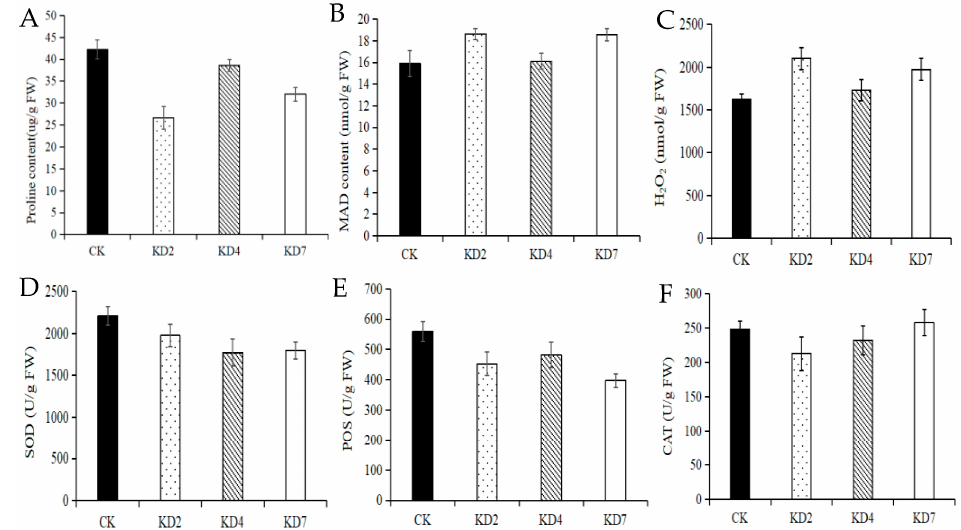
Figure 5. The drought-relevant physiological indexes between transgenic potato lines and CK. ( A ) The content of proline, ( B ) the content of MDA, ( C ) the content of H 2 O 2 , ( D ) the enzyme activity of SOD, ( E ) the enzyme activity of POD, and ( F ) the enzyme activity of CAT.